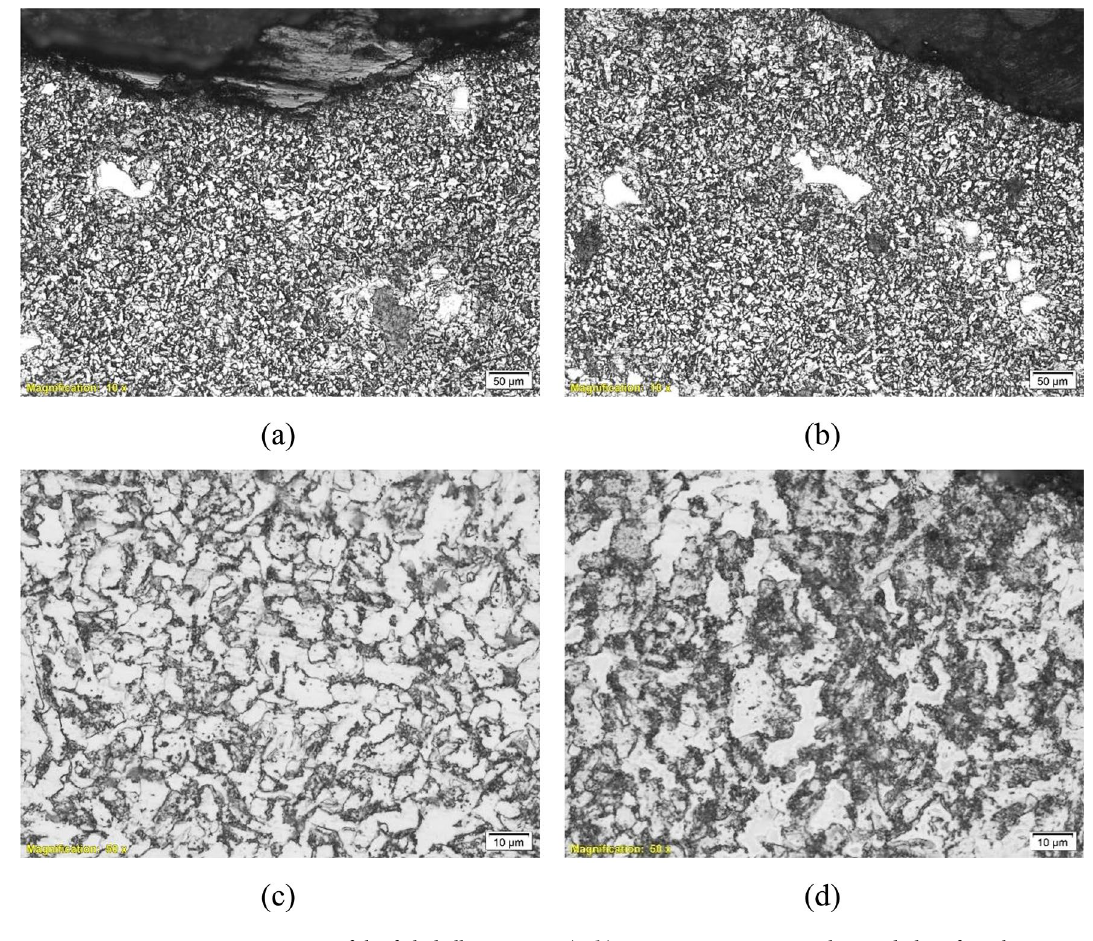
Figure 13. Microstructure of the failed elbow UN19: ( a , b ) cross-section at external corroded surface showing large areas of ferrite (white islands) and large level of pearlite (dark areas), and ( c , d ) larger magnification showing spheroidized carbides or partially transformed/decomposed austenite microstructure.